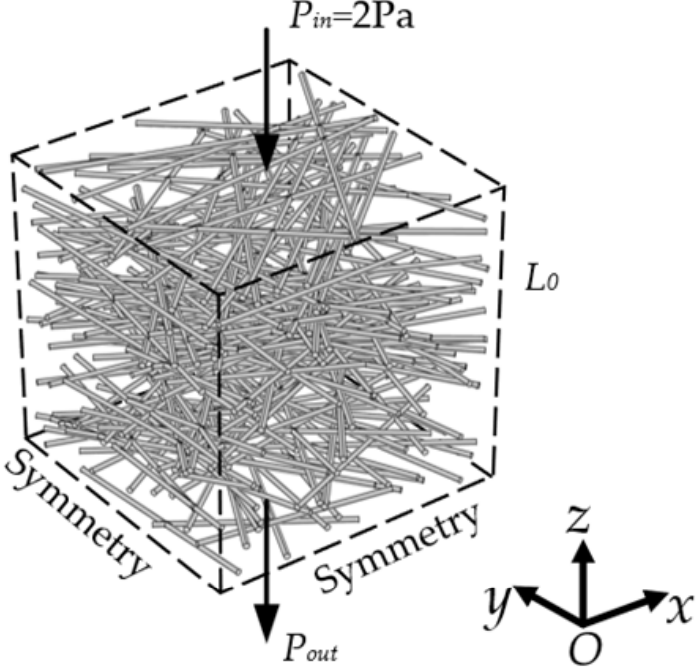
Figure 4. The physical model of 3D fibrous porous material with boundary conditions. In order to validate the present fractal model, the through-plane permeability by FEM under the same ratio of minimum to maximum of pore size ( λ min / λ max = 0.4) and the dimensionless permeability by fractal model (Equation (24)) were compared and are listed in Table 1. It should be noted that the through-plane permeability error between fractal model and numerical is within 5%, which indicates that the fractal model agrees well with numerical